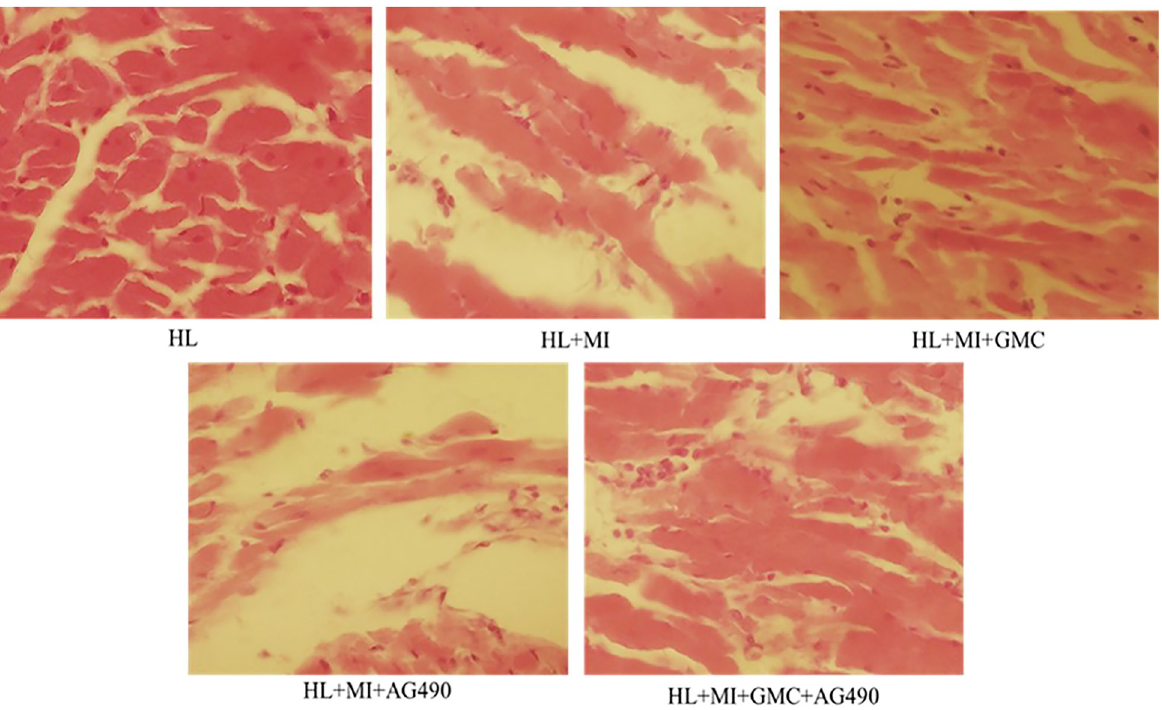
Figure 4: The effects of GMC administration on myocardial histological changes induced by ischemia-reperfusion injury and their reversal by AG490 in hyperlipidemic (HL) rats.